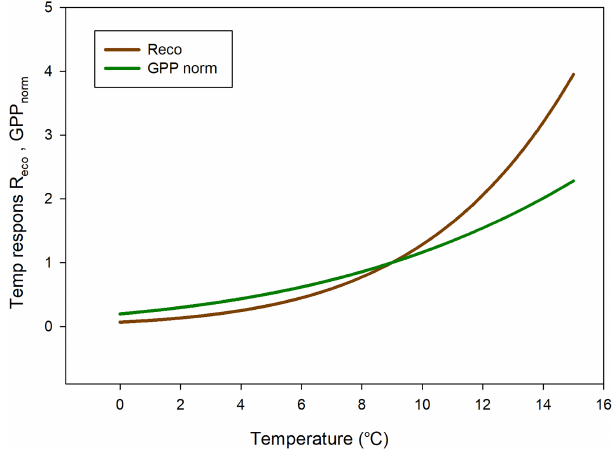
Figure 13. Box plot of CH 4 fluxes (FCH 4 ) per sampling location named N1–N3 and S1–S3. The statistics includes also the data that fall within the flux detection limits. The boundaries of the grey boxes represent the 25th and 75th percentiles, the line represent the median, and whiskers above and below the boxes indicate the 10th and 90th percentiles. Outlying points are also